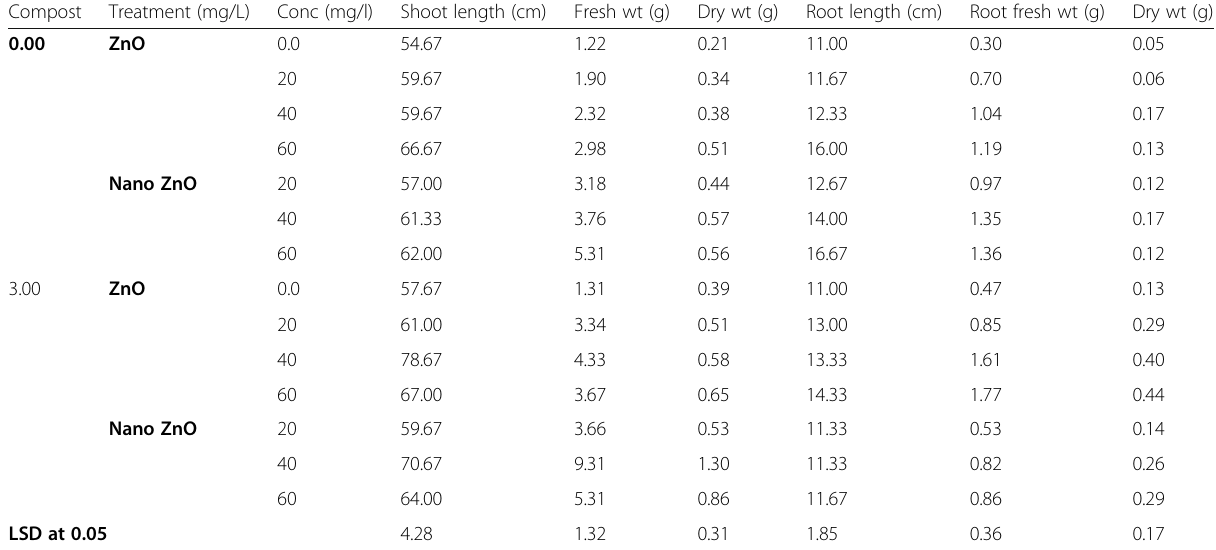
Table 4 Effect of compost (0.0 or 3.0 ton/fed) and/or ZnO or nano ZnO (0, 20, 40, and 60 mg/l) on growth criteria of flax plant under sandy soil